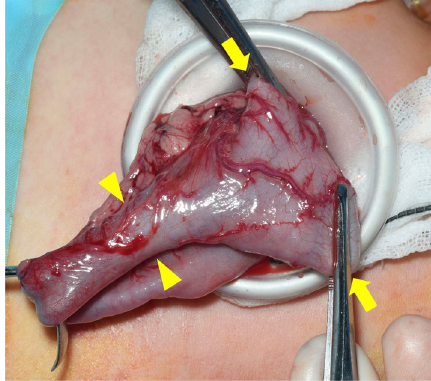
Fig. 4 Intraoperative findings. The normal-sized transverse colon (arrowheads) on the oral side of the dilated colon (arrows) was elevated from the umbilical incision and